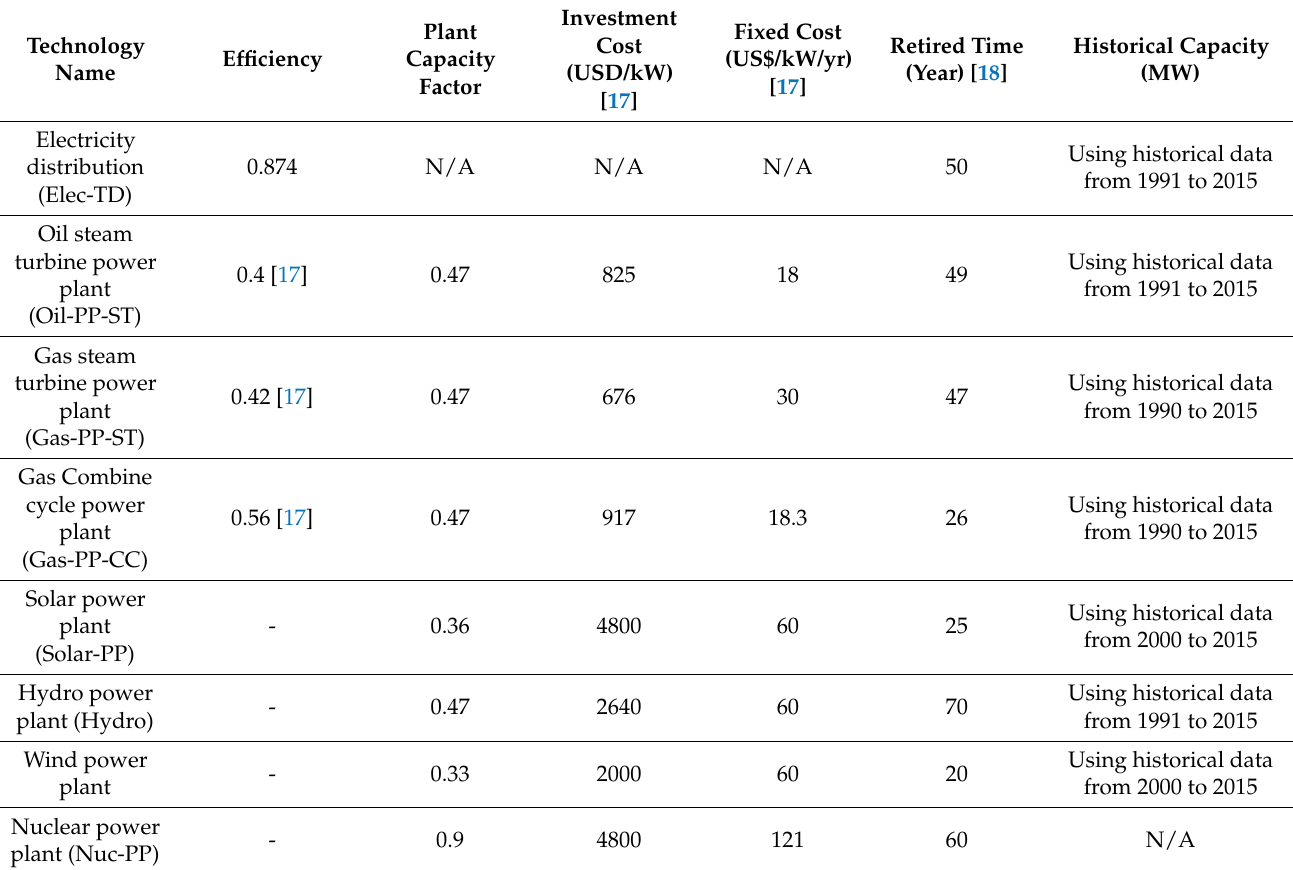
Table 2. Input parameters of the technologies in